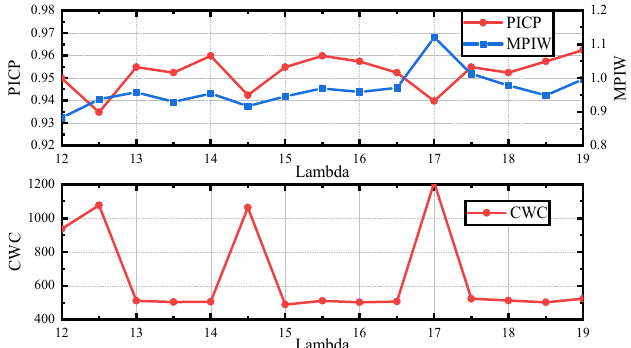
Figure 6. Relationship between the weight parameter and the value of PICP, MPIW and CWC when using QD loss.